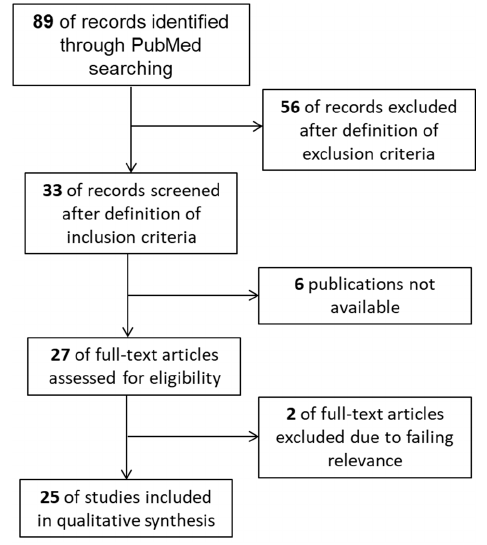
Figure 1. Flow diagram containing the process of study selection.